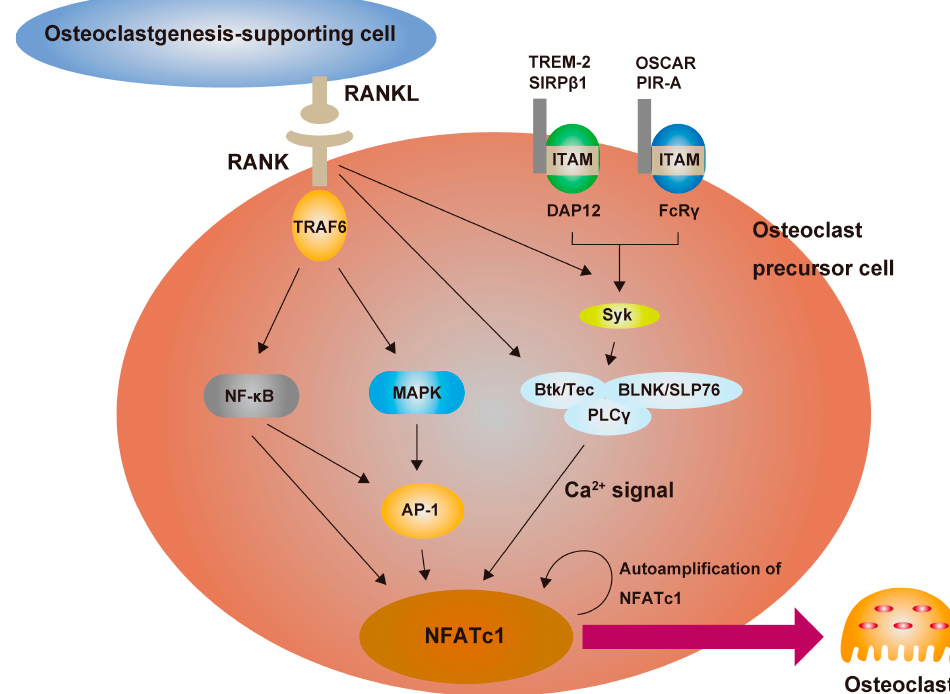
Figure 2. RANKL signal transduction in osteoclastogenesis. Osteoclastogenesis-supporting cells, such as osteoblasts, osteocytes, and synovial fibroblasts, express receptor activator of NF- κ B ligand (RANKL) and bind to receptor activator of NF- κ B (RANK) on osteoclast precursor cells. RANKL- RANK binding recruits tumor necrosis factor receptor-associated factor 6 (TRAF6), which activates NF- κ B and mitogen-activated protein kinase (MAPK) signaling pathways, leading to activation of the downstream factors such as activator protein 1 (AP-1). Immunoglobulin-like receptors such as triggering receptor expressed on myeloid cells 2 (TREM-2), signal-regulatory protein β 1 (SIRP β 1), osteoclast-associated receptor (OSCAR), and paired immunoglobulin-like receptor A (PIR-A), which associate with DNAX activating protein of 12 KDa (DAP12) or Fc receptor γ -chain (FcR γ ), are essential molecules in transmitting co-stimulatory signals required for osteoclast differentiation. Immunoreceptor tyrosine-based activation motifs (ITAMs) are phosphorylated by both RANKL signal and immunoglobulin-like receptors signal, leading to activation of Ca2+ signaling through spleen tyrosine kinase (Syk) and complexes involving Tec kinases Btk/Tec, adaptor proteins such as B cell linker protein (BLINK)/Src homology 2 domain-containing leukocyte protein of 76 kDa (SLP76), and phospholipase C γ (PLC γ ). Ca2+ signaling induces activation and auto-amplification of nuclear factor of activated T cells 1 (NFATc1), ultimately determining osteoclast differentiation.